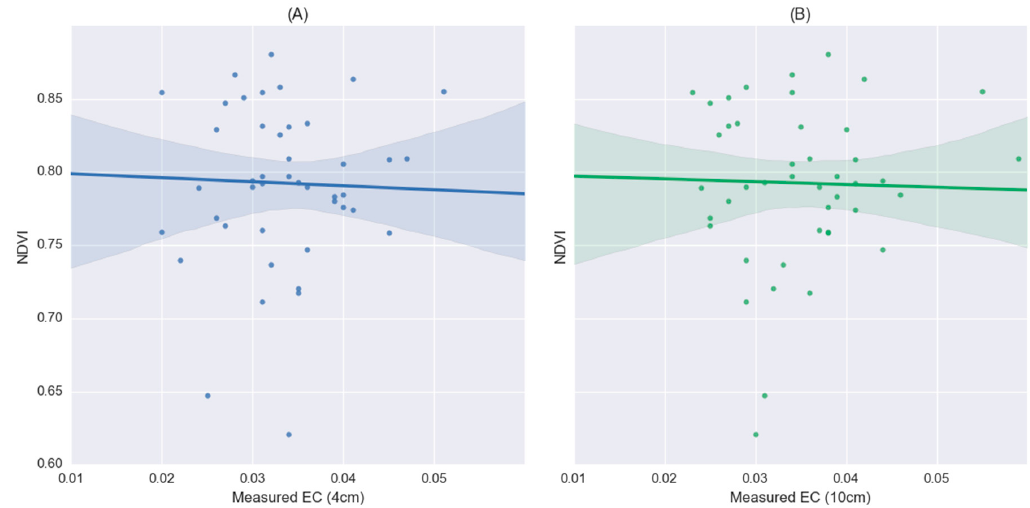
Figure 4. Correlation between NDVI soil salinity (EC) at the depths of 4 cm ( A ) and 10 cm ( B ).